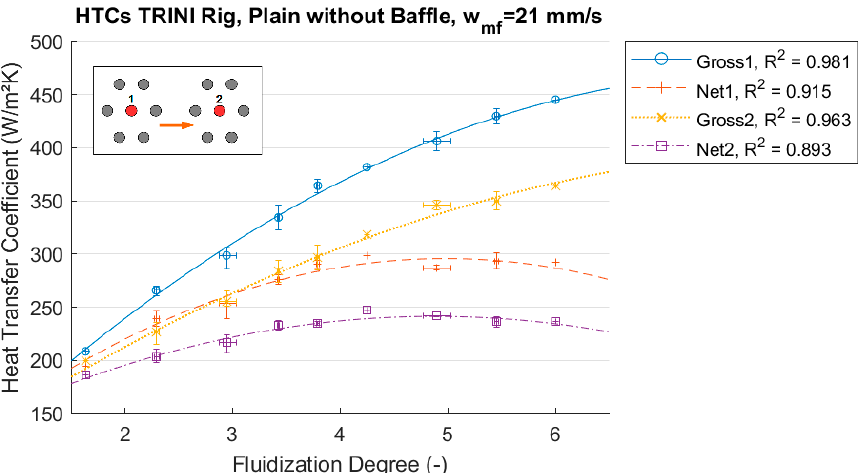
Figure 12. Plain tube results without the use of baffles, TRINI test rig, 146 µm particles. Indices 1 and 2 refer to the different heated tubes.